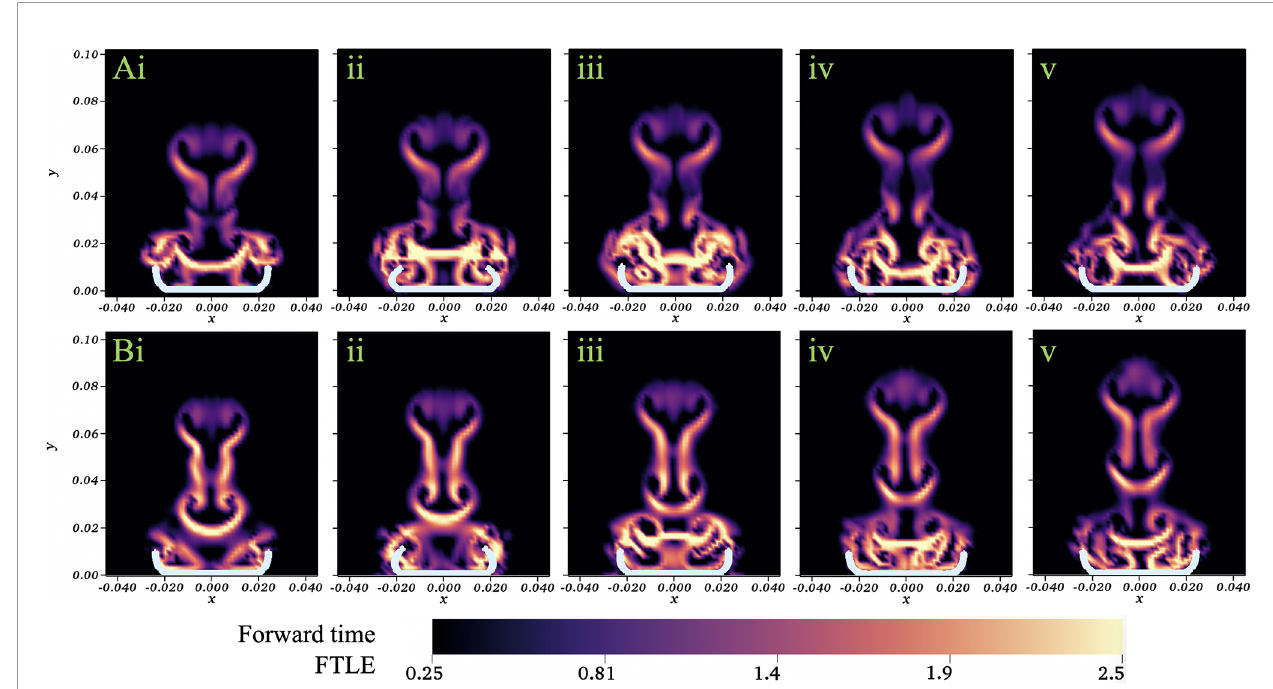
FIGURE 13 | Colormap showing the FTLE values for a numerical simulation with no substrate (A) and resting against the substrate (B) . Snapshots show the beginning of the fourth stroke cycle (i) and 20%, 40%, 60%, and 80% through the stroke cycle (ii-v). Axes scales given in units of m.